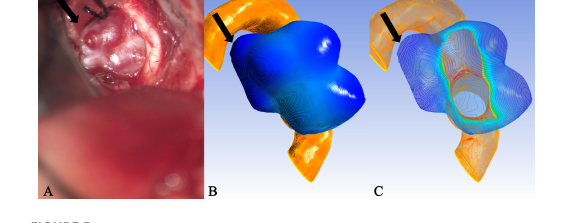
FIGURE5 Case 35: An unruptured anterior communicating aneurysm. (A) There existed many translucent areas on the surface of a aneurysm entity. They all corresponded one-to-one with the deeply stained areas of the cloud map in (B) and the extreme points of (C) , but because of the limitation in the surgical visual field, some extreme points were located in the blind area of the surgical field [ (A) , black arrow], therefore, they failed to be observed and confirmed.